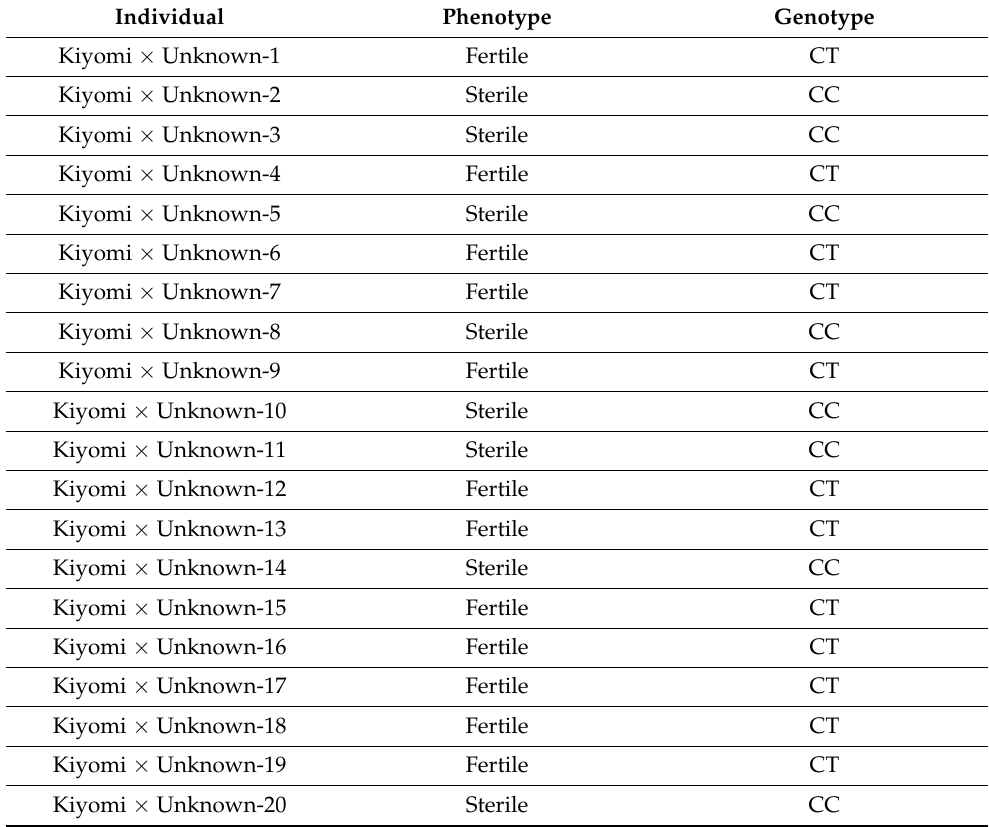
Table 3. Genetic analysis of 20 hybrids recovered with ‘Kiyomi’ as a female parent and an unknown male parent, with the S08_6142645 SNP marker associated to male sterility. Individual Phenotype